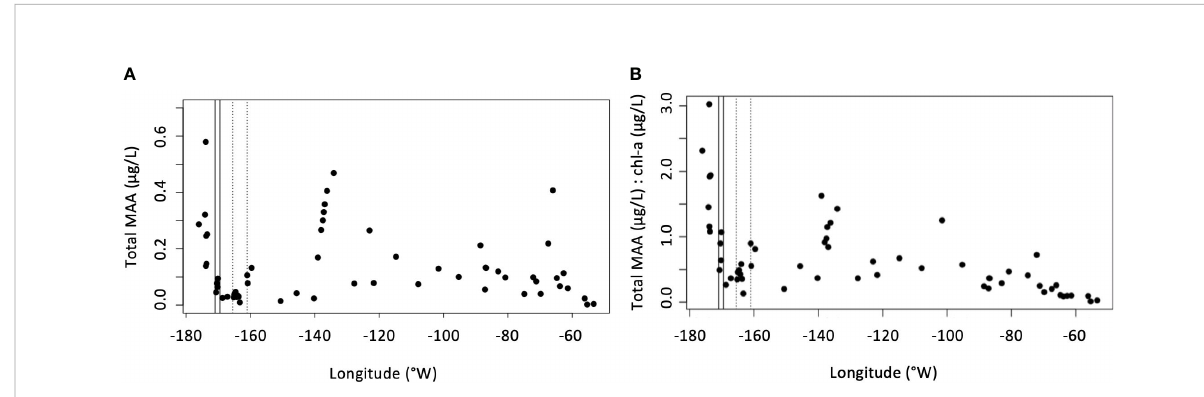
FIGURE 5 (A) Sum of all MAAs ( m g/L) across the transect of the ANA08D 2018 research expedition. (B) Ratio of sum of all MAAs ( m g/L) to chl-a ( m g/L) across the transect of the ANA08D 2018 research